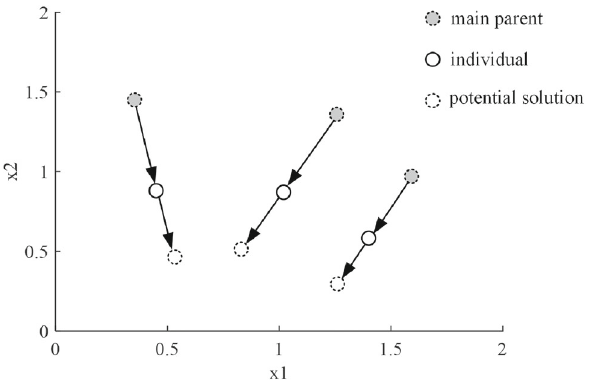
Fig. 1 The definition of search inertia. Individuals are searching along the direction of the previous generation